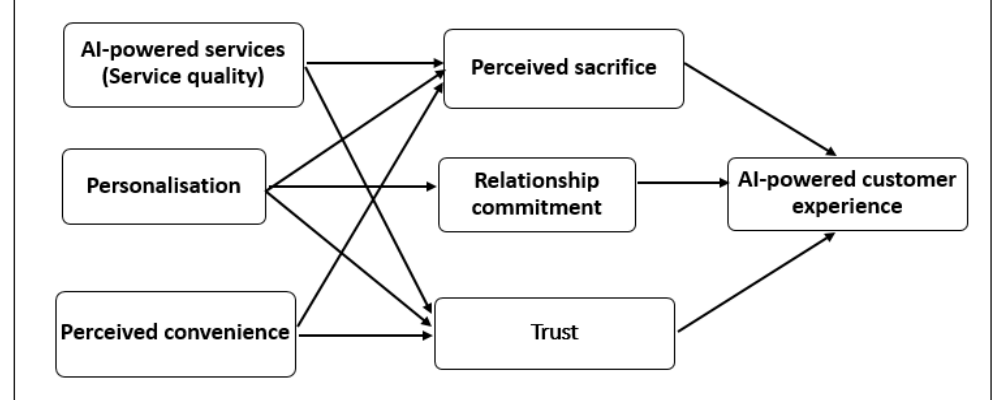
Fig. 1. AI-Powered Customer Experience Proposed